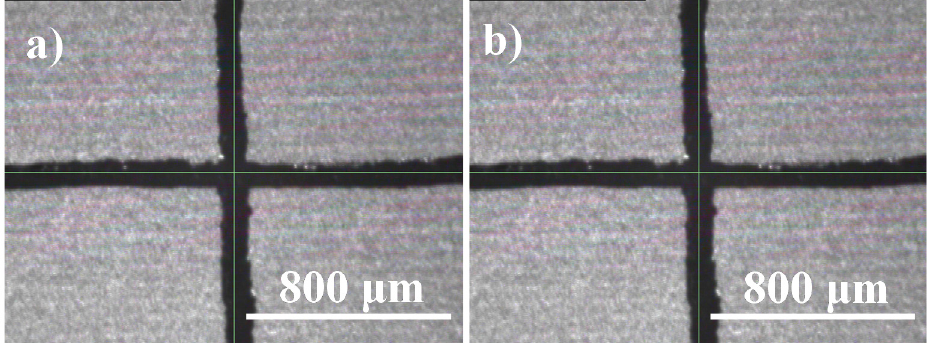
Figure 11. ASTM tape test: ( a ) before tape test ( b ) image after tape pull of using Fiducial camera.